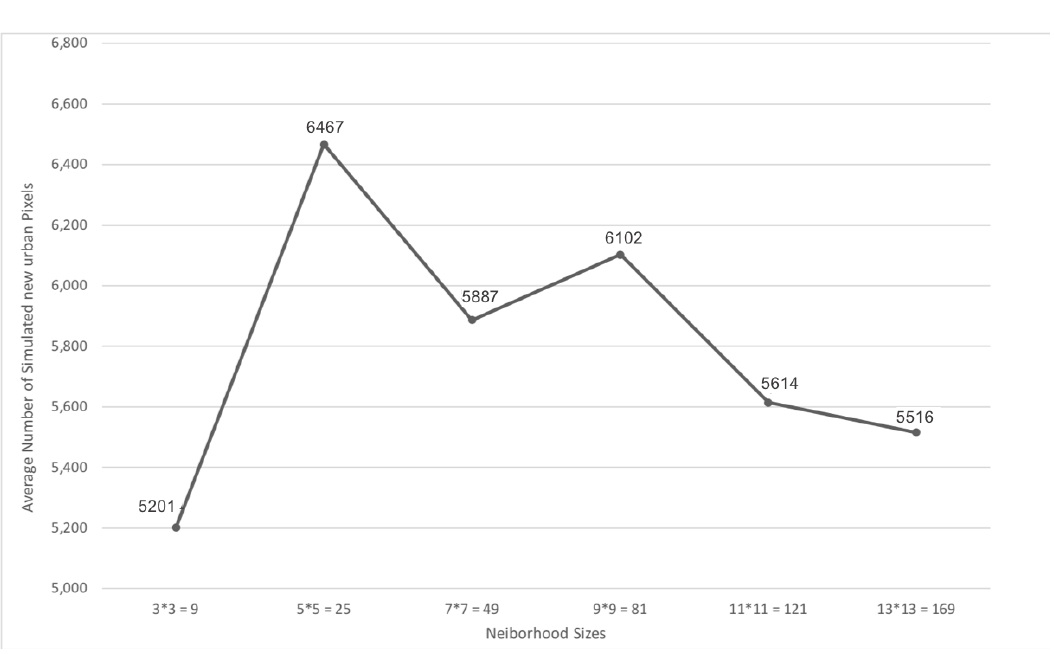
Figure 4. Parameter tests on different neighborhood sizes, with a fixed urban ratio of 0.375. Each value represents an average of 10